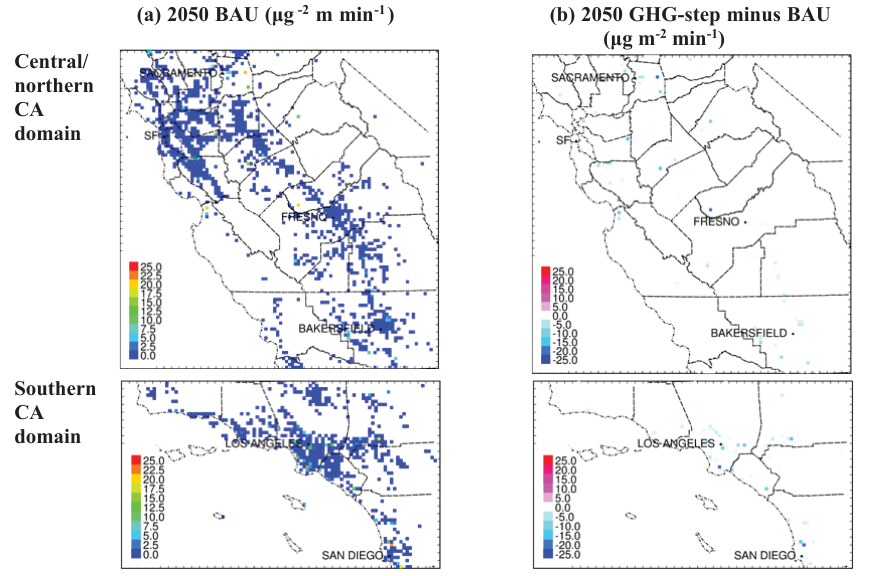
Figure 16. Particulate matter emissions from electricity generation (emissions source category type 6) in the BAU scenario (a) and emissions change in the GHG-Step scenario (b) . Units are µgm − 2 min − 1